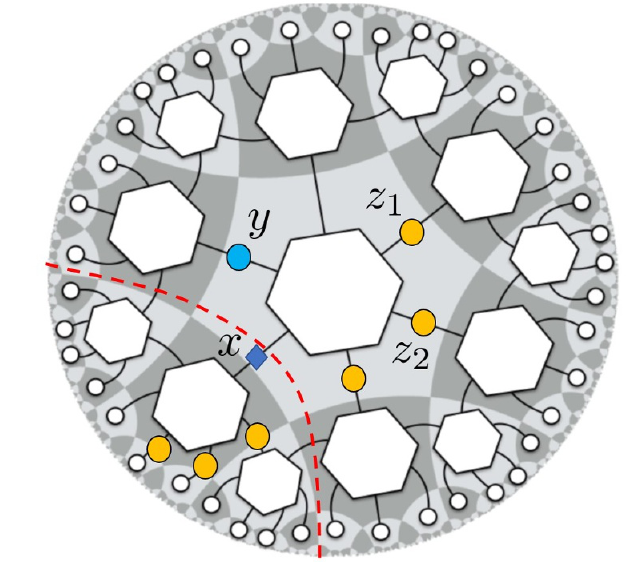
Figure 18 . A hyperbolic perfect tensor network in which y is not in the future of x , as U x can be pushed to the boundary only using the circuit on the left-side of the geodesic (red dashed line). A multi-site region such as z (6 yellow links) can be causally in(cid:13)uenced by x since there is